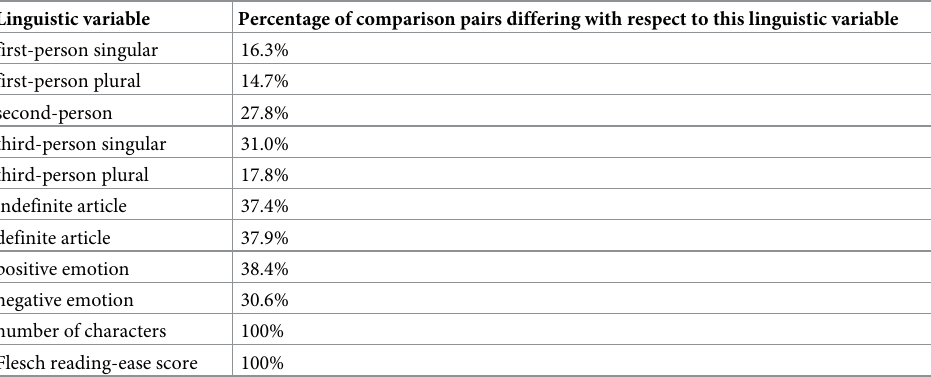
Table 3. Linguistic variables and the frequency in which they are manipulated among the comparison pairs. Linguistic